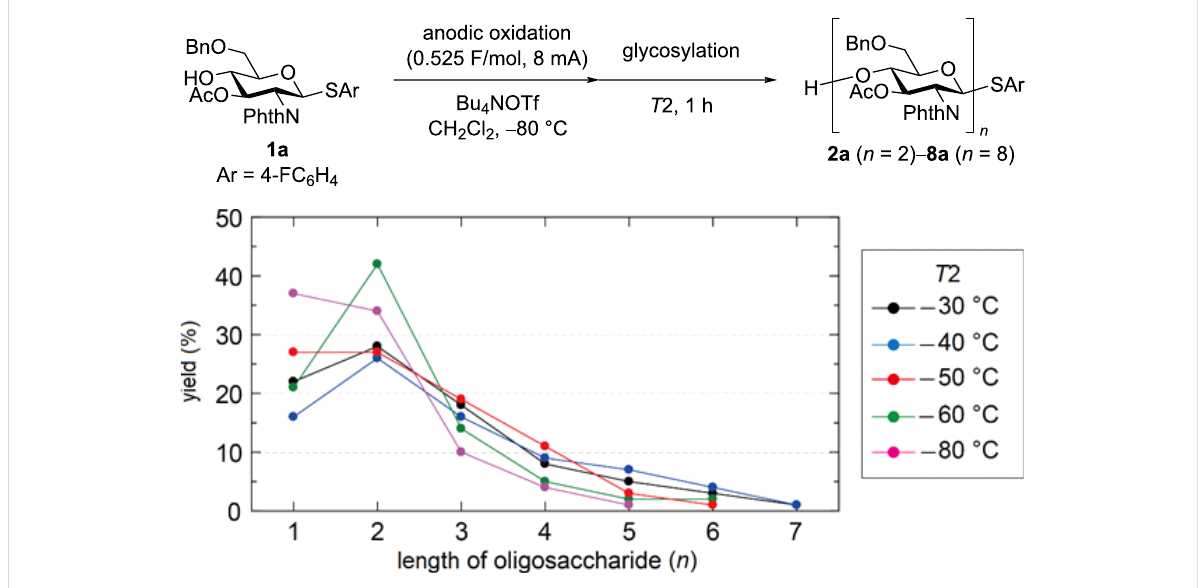
Figure 3: Influence of the glycosylation temperature ( T 2) on the yield of oligosaccharides.